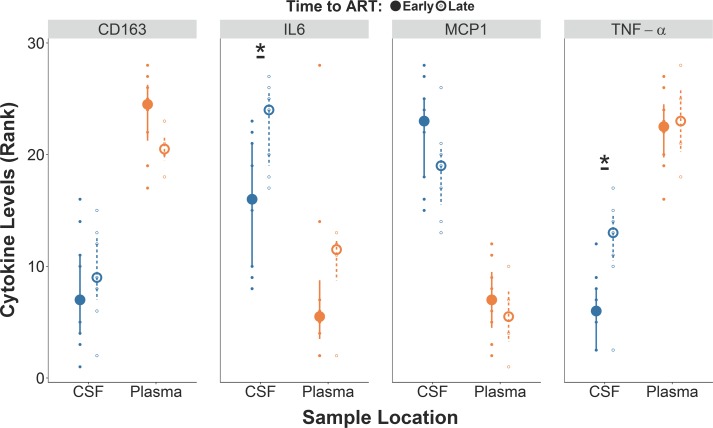
Levels of CSF inflammatory markers were lower in the early ART group in comparison to late ART group.Comparison between early ART versus late ART groups for rank-transformed levels of CD163, IL-6, MCP1, and TNF-α. *p<0.05. Small and large dots present rank-transformed data and medians while the error bars represent interquartile ranges.